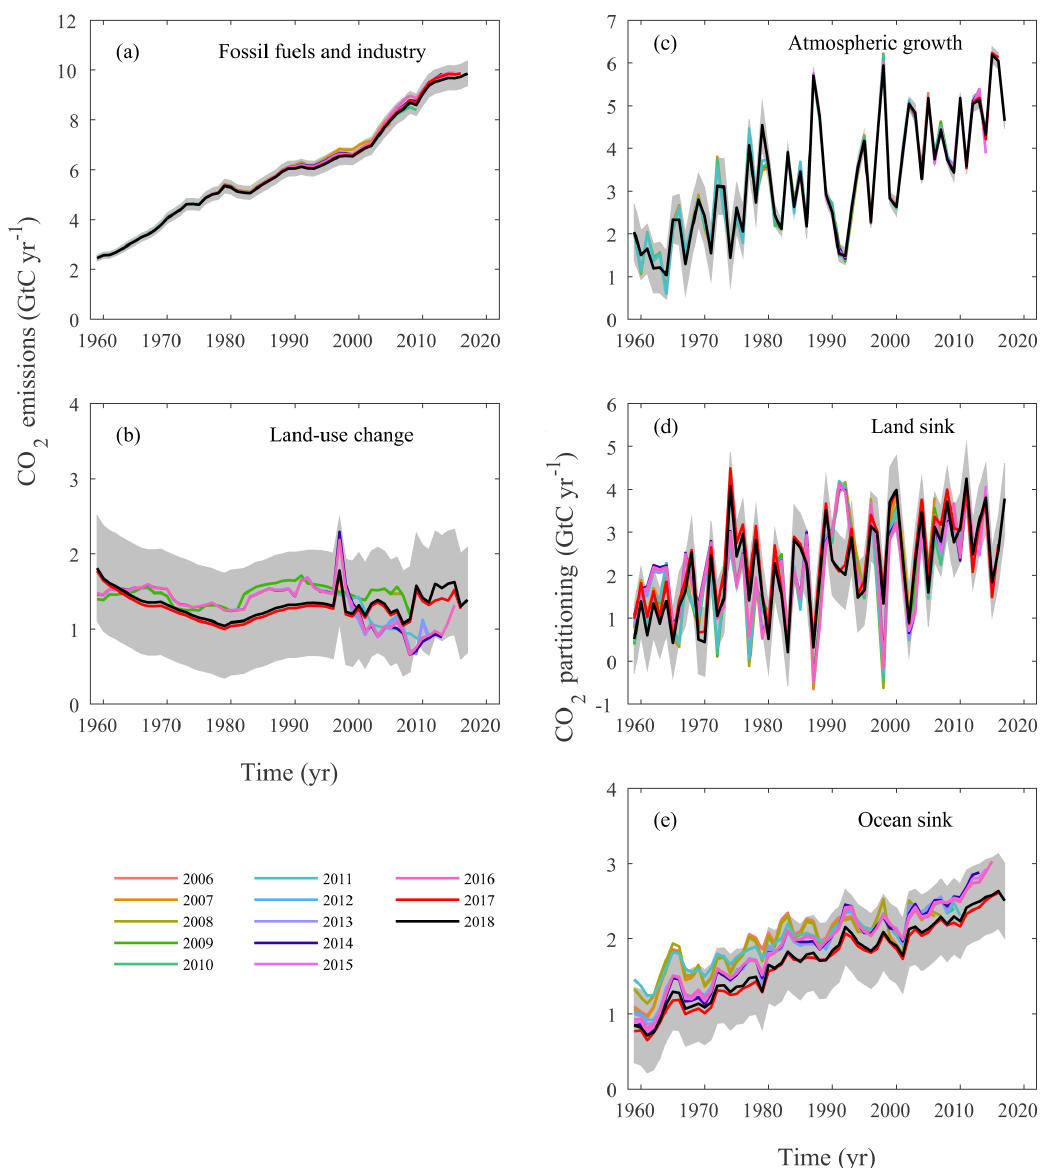
Figure B4. Comparison of global carbon budget components released annually by GCP since 2006. CO 2 emissions from (a) fossil CO 2 emissions ( E FF ) and (b) land-use change ( E LUC ), as well as their partitioning among (c) the atmosphere ( G ATM ), (d) the land ( S LAND ), and (e) the ocean ( S OCEAN ). See legend for the corresponding years and Table 3 for references. The budget year corresponds to the year when the budget was first released. All values are in GtCyr − 1 . Grey shading shows the uncertainty bounds representing ± 1 σ of the current global carbon